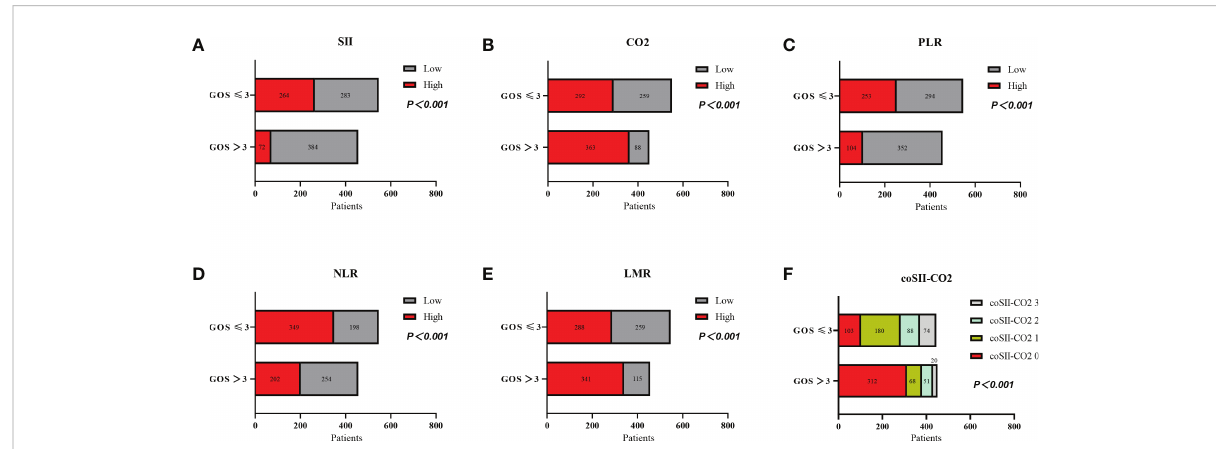
FIGURE 2 Relationships among levels of SII, CO 2 , PLR, NLR, and LMR, and coSII-CO 2 and GOS in patients with severe TBI. (A) Patients with high SII ≥ 2651.43 had poorer GOS than patients with low SII<2651.43 (P < 0.001). (B) Patients with low CO 2 <22.15 had poorer GOS than patients with high CO 2 ≥ 22.15 (P < 0.001). (C) Patients with high PLR ≥ 190.98 had poorer GOS than patients with low PLR<190.98 (P < 0.001). (D) Patients with high NLR ≥ 9.66 had poorer GOS than patients with low NLR<9.66 (P < 0.001). (E) Patients with low LMR<1.5 had poorer GOS than patients with high LMR ≥ 1.5 (P < 0.001). (F) GOS scores of patients: coSII-CO 2 0 > coSII-CO 2 1 > coSII-CO 2 2 > coSII-CO 2 3 (P <